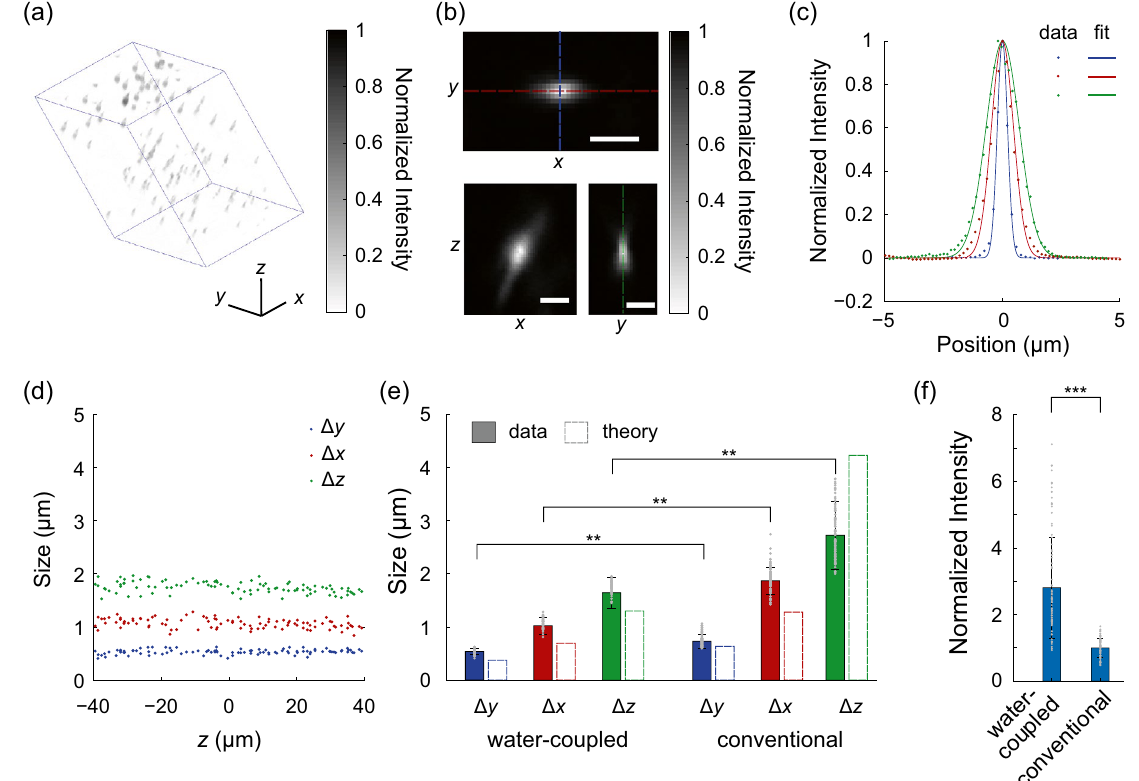
Figure 2. Water-coupled SCAPE resolved fluorescent beads with high resolution and light capture. ( a ) Three- dimensional render of 0.2 µm fluorescent beads embedded in agarose. Scale bars along the axes markers are 30 µm. Blue lines outline the imaged volume. ( b ) Projections of a typical bead along the Cartesian directions. Scale bars are 2 µm. ( c ) Fits of the projections along color-matched dashed lines in ( b ) to Gaussian functions showed that the example bead had FWHMs in the x , y , and z directions of 1.0 µm, 0.52 µm, and 1.6 µm, respectively. ( d ) The fits of beads were relatively constant for beads located at different depths of the sample. ( e ) We compared bead spot FWHMs within 50 µm of the principal imaging plane between the water-coupled and conventional SCAPE platforms. The water-coupled SCAPE significantly outperformed the conventional SCAPE in resolution along all directions. The experimental FWHM most lagged theoretical calculations, except for cases of large Δ z that were impacted by the excitation PSF. ** represents p < 10 −38 , two-sided Wilcoxon rank- sum test, n = 139 beads imaged by water-coupled SCAPE, and 194 beads imaged by conventional SCAPE. ( f ) The water-coupled SCAPE outperformed conventional SCAPE in the intensity of imaged beads. The intensity of both sets of beads imaged by the two microscopes was normalized by the mean intensity of the set of beads imaged by conventional SCAPE. ***Represents p < 10 −110 , two-sided Wilcoxon rank-sum test, n = 633 beads imaged by water-coupled SCAPE, and 714 beads imaged by conventional SCAPE. All experiments used 1.0 mW at the sample. The distance between planes was 0.062 µm, and the exposure time was 30 ms per layer. Gray points in ( e ) and ( f ) represent data from individual beads, with 100 randomly selected data points